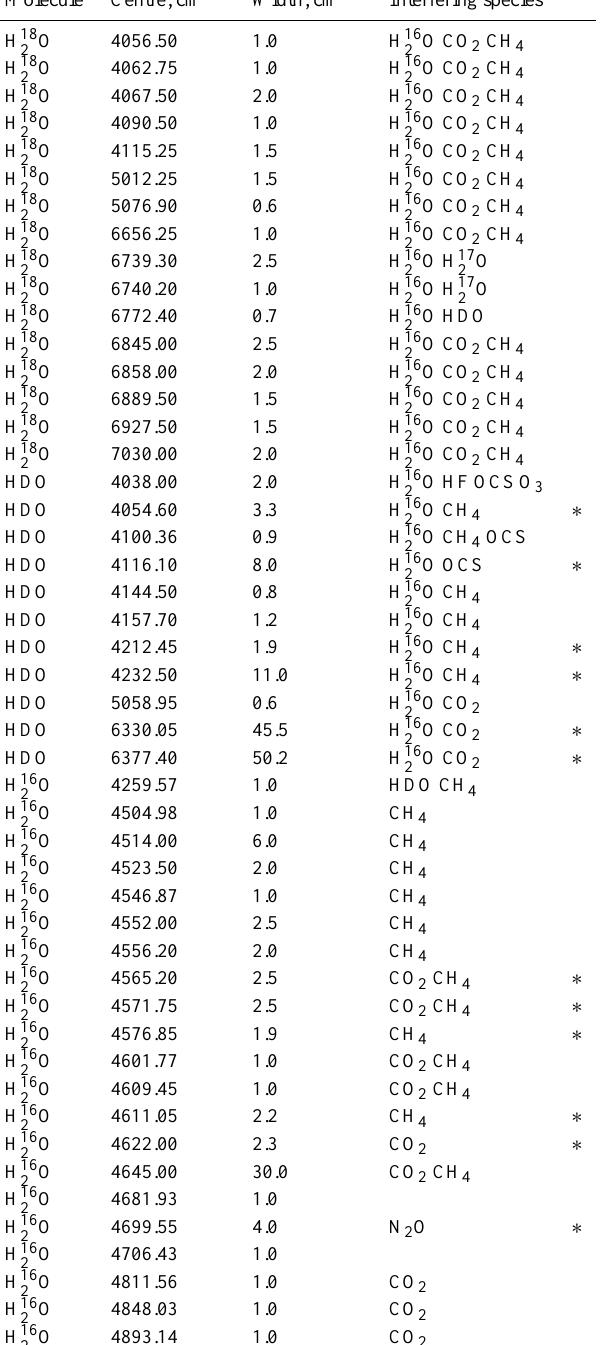
Table 1. Summarized information about spectral windows used for the retrieval of H 16 O, H 18 O and HDO. Windows marked by “ ∗ ” are 2 2 used in the TCCON community.